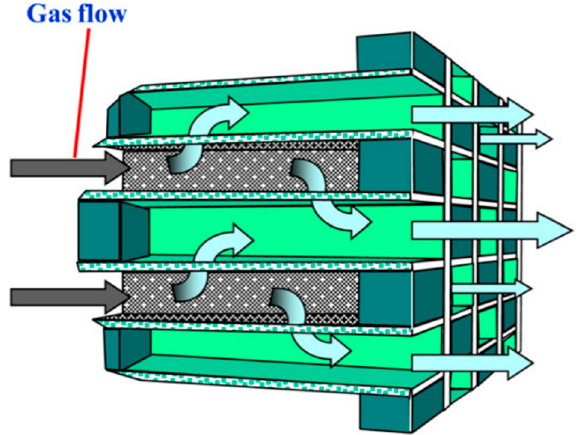
Figure 6. Structure schematic diagram of wall-flow diesel particle filter [87].